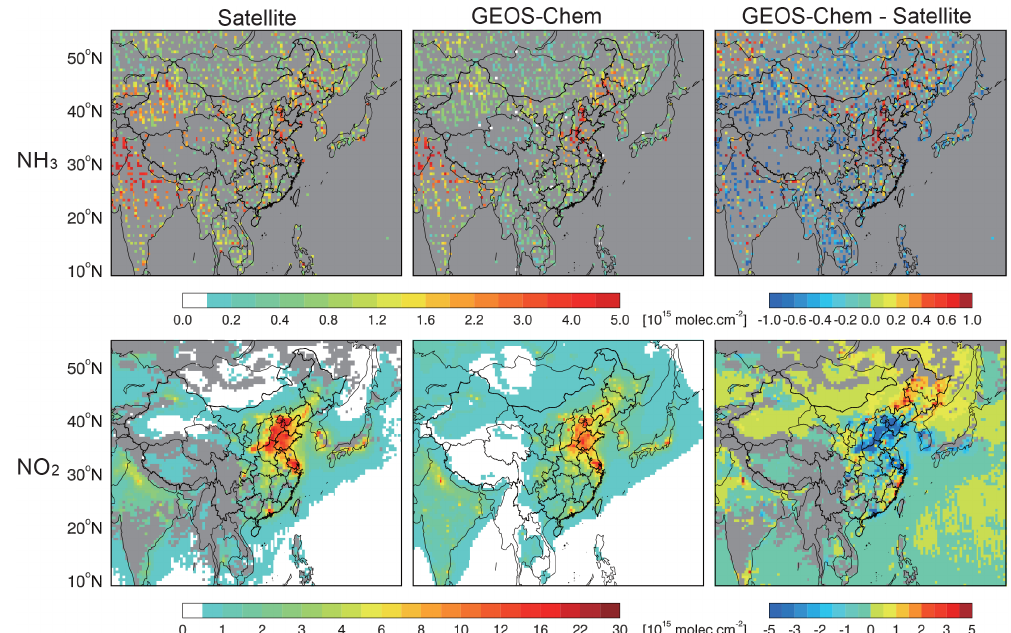
Figure 2. Satellite observations of NH 3 tropospheric columns from TES (top left) and NO 2 tropospheric columns from ozone monitoring instrument (OMI) (bottom left). The TES observations are daytime measurements during June–August 2005–2010. The OMI observations during March–November 2009 are from KNMI at 0.125 ◦ × 0.125 ◦ resolution. Both are re-grided to the model resolution (1 / 2 ◦ × 2 / 3 ◦ ). The middle panels show corresponding GEOS-Chem model results for 2009 sampled at the satellite overpass time (13:45LT). The right panels show the GEOS-Chem minus satellite